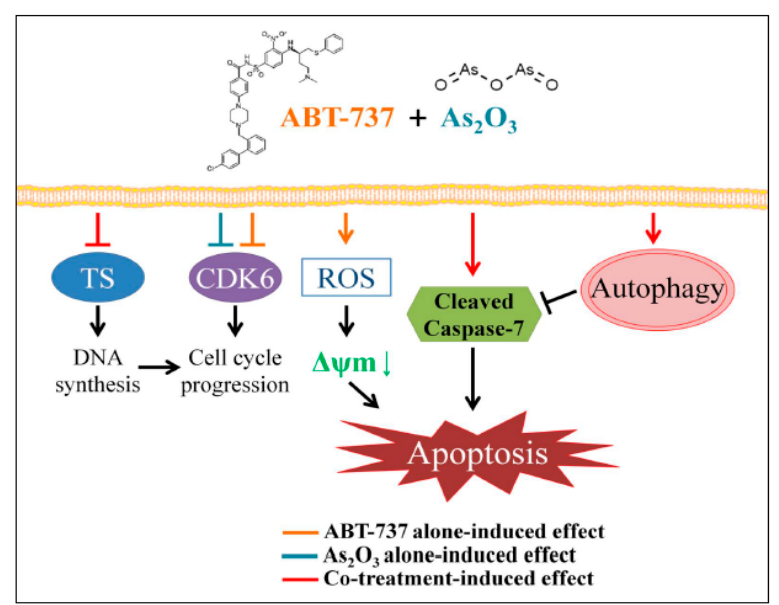
Figure 7. A suggested model of ABT-737 combined with As 2 O 3 inducing cell death in SiHa cells.